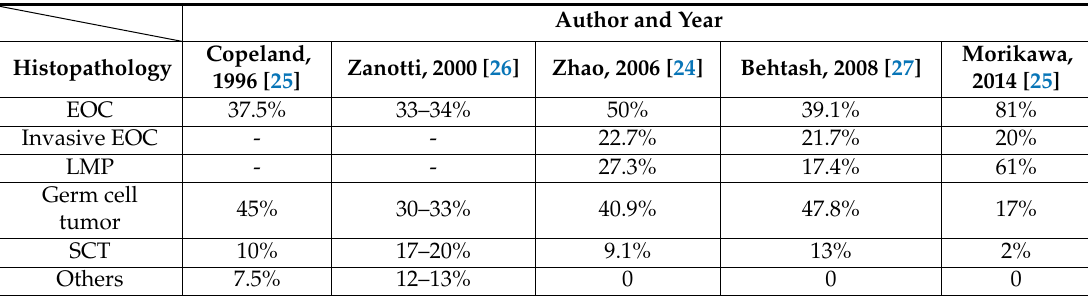
Table 1. Frequency of ovarian cancer in pregnancy by tumor histology in the